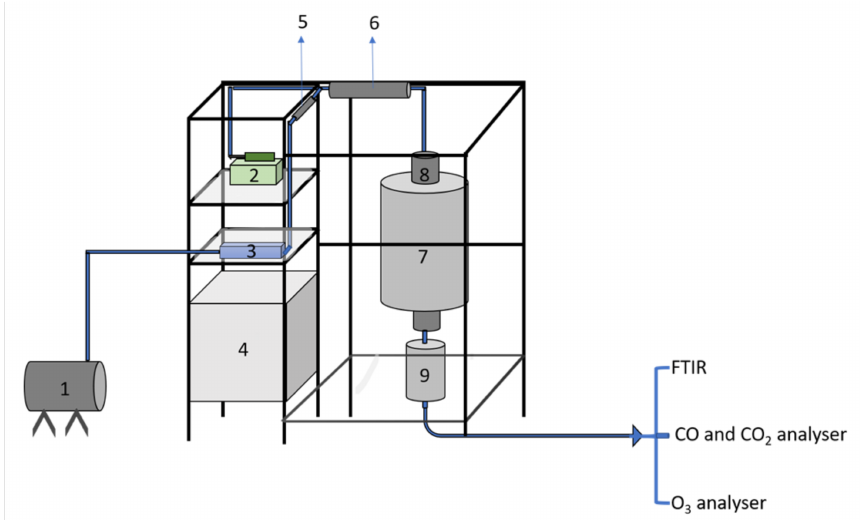
Figure 8. Experimental setup 1. Air compressor; 2. Syringe pump; 3. Rotameter; 4. Control unit; 5. Vaporiser; 6. Mixing chamber; 7. Heating coil (oven); 8. Stainless steel reactor; 9.